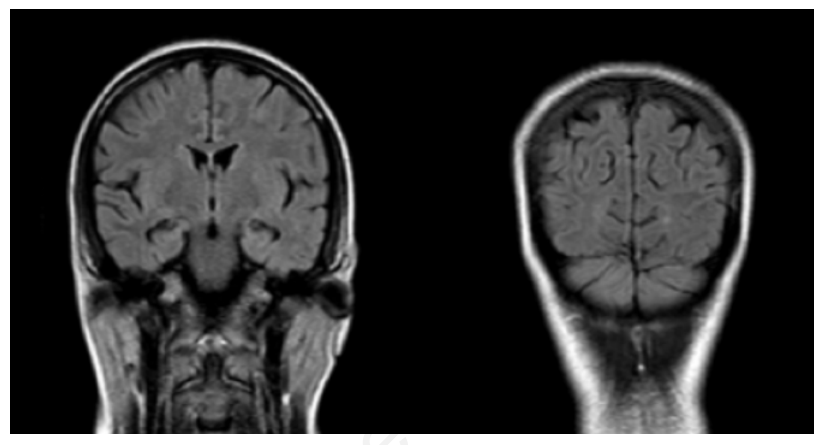
Figure 4. Brain MRI findings were normalized by 3th month after eculizumab treatment.